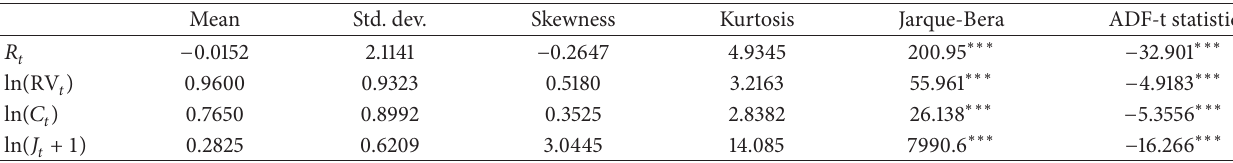
Table 1: Descriptive statistics for each variable.